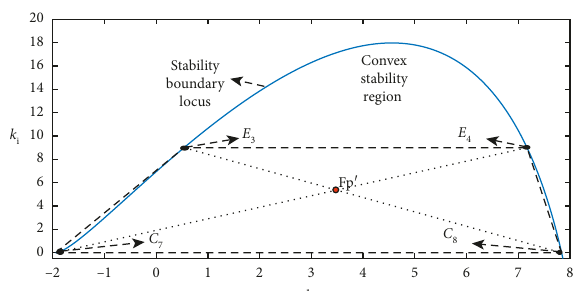
Figure 21: Changed convex stability region and Fermat point of PI controller in example E.